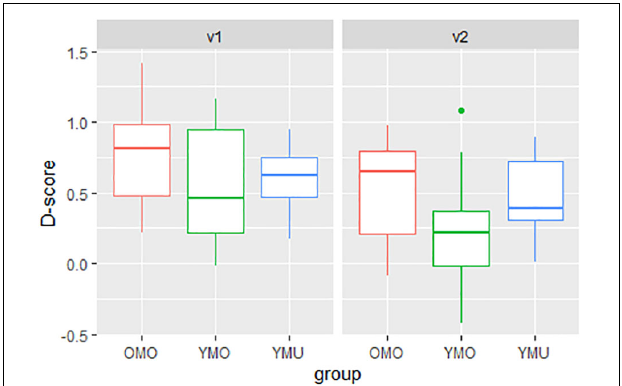
FIGURE 7 | Distributions of D -scores (pronunciation effect, y -axis) as a function of listener group (YMU, YMO, and OMO) and order (test version v1, v2) for the FR-experiment.